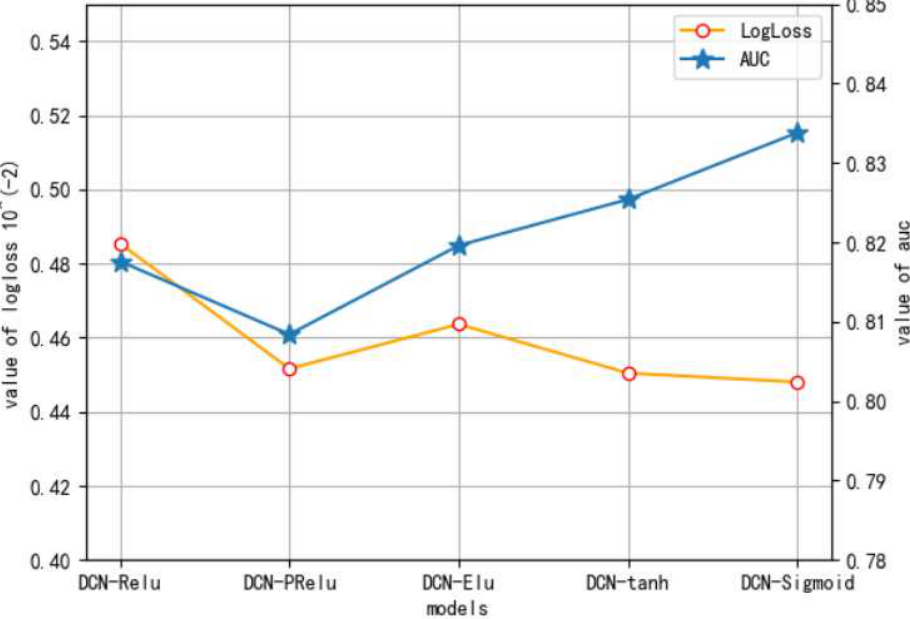
Figure 6. The comparison of DCN model with different activation